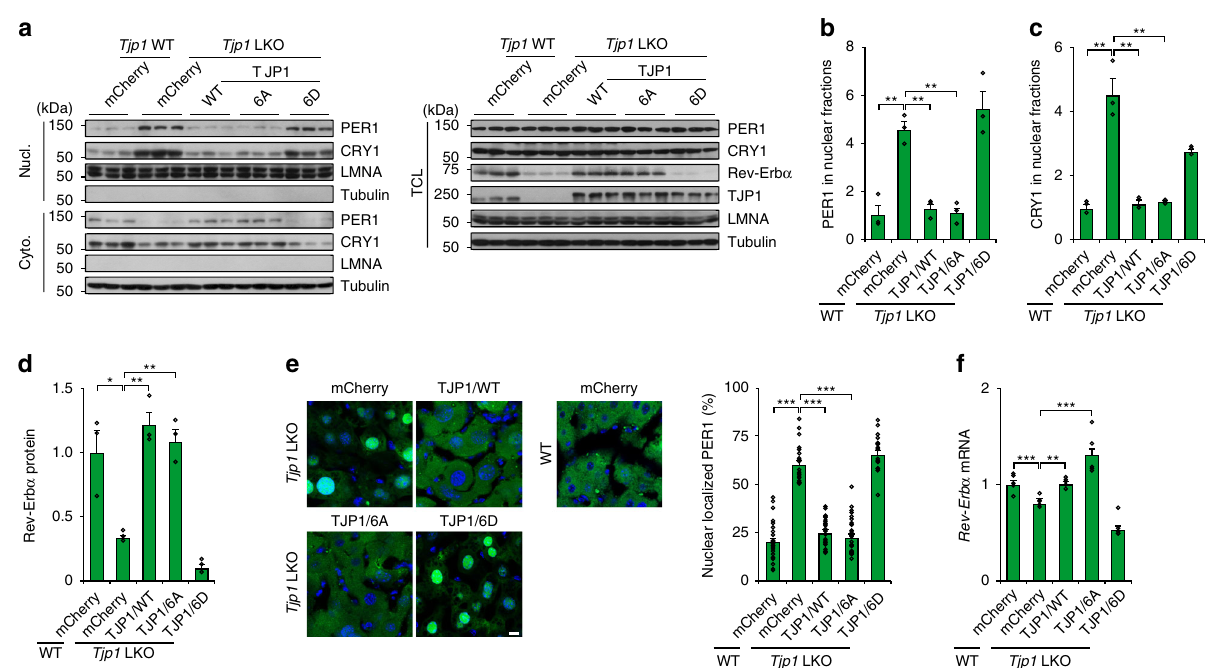
Fig. 3 Phosphorylation of TJP1 promotes PER1 nuclear translocation. a – d Effect of TJP1 or its mutants on cellular localization of PER1 in the liver evaluated by immunoblots a , and statistical analysis of PER1 b , CRY1 c in Nucl. and Rev-Erb α in TCL d of liver extracts harvested from mice at ZT6. e and f Effect of TJP1 or its mutants on cellular localization of GFP-PER1 e , and Rev-Erb α expression f in liver extracts harvested from mice at ZT6. 6A is the T589A/T709A/ S927A/S1360A/S1460A/S1617A mutant of human TJP1, while 6D is the T589D/T709D/S927D/S1360D/S1460D/S1617D mutant of human TJP1. Data are shown as mean ± s.e.m. Comparison of different groups was carried out using one-way ANOVA. *P < 0.05, **P < 0.01, ***P < 0.001, n = 5 mice. Source data are provided as a Source Data fi le.